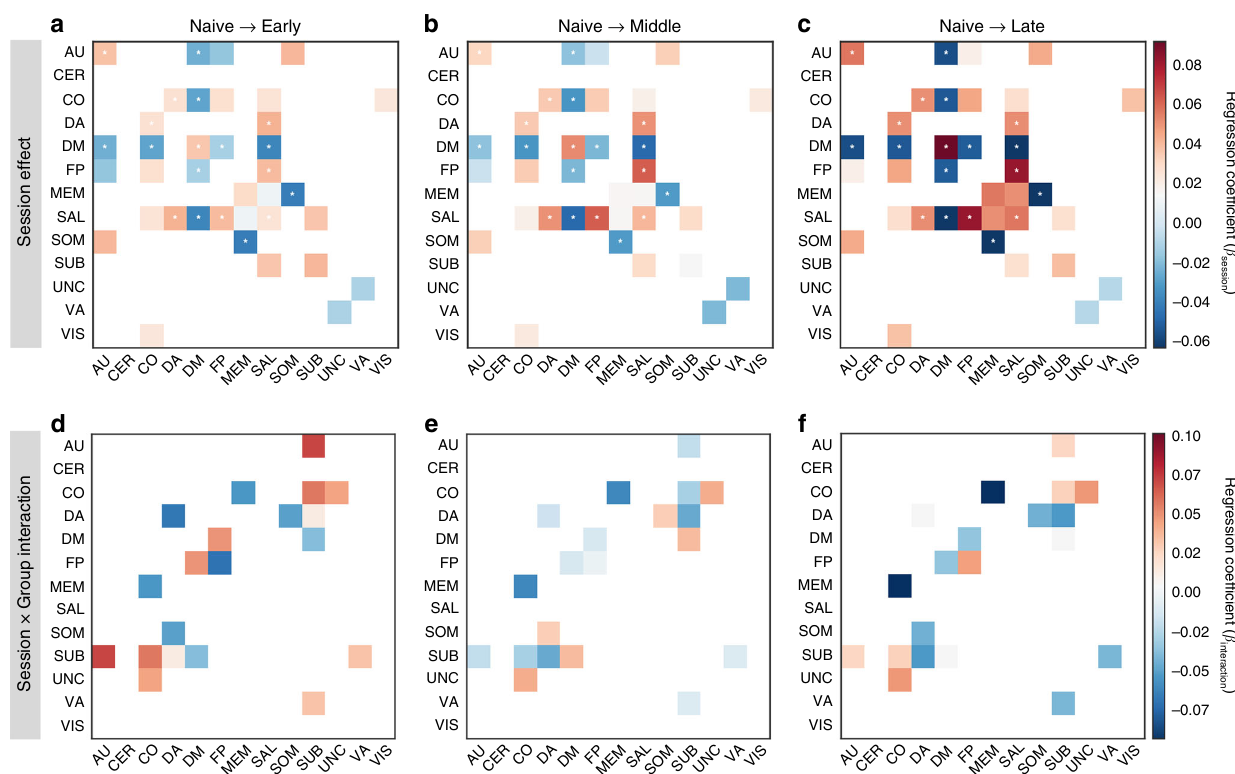
Fig. 6 Changes of the recruitment and integration of large-scale systems. Colored tiles represent all signi fi cant effects ( p < 0.05, uncorrected; * p < 0.05 FDR-corrected). (top panel) Here, we display the signi fi cant main effects of session. Tile color codes a linear regression coef fi cient ( β ), for all main session effects: a from “ Naive ” to “ Early ” , b from “ Naive ” to “ Middle ” , and c from “ Naive ” to “ Late ” . (bottom panel) Here, we display the signi fi cant session × group interaction effects. Tile color codes a linear regression coef fi cient between groups and sessions: d from “ Naive ” to “ Early ” , e from “ Naive ” to “ Middle ” , and f from “ Naive ” to “ Late ” . AU: auditory, CER: cerebellum, CO: cingulo-opercular, DM: default mode, DA: dorsal attention, FP: frontoparietal, MEM: memory, SAL: salience, SOM: somatomotor, SUB: subcortical, UNC: uncertain, VA: ventral attention, VIS: visual. Source data are provided as a Source Data fi le.